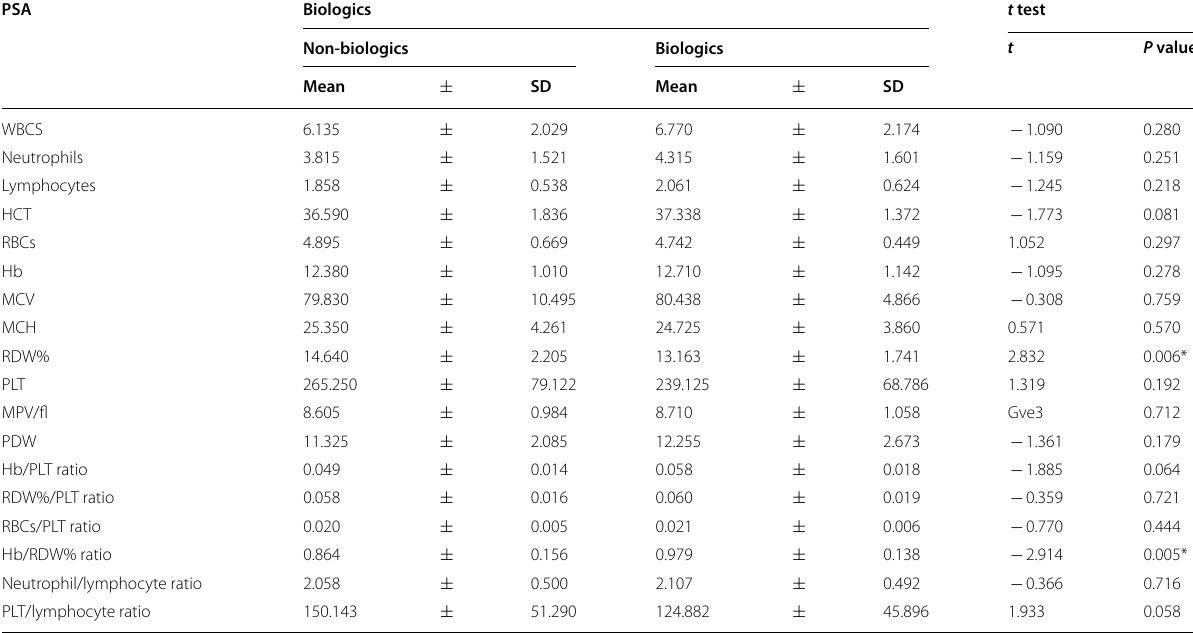
Table 3 Comparison between PSA patients with and without biologic therapy as regards WBCs, RBCs, platelets indices